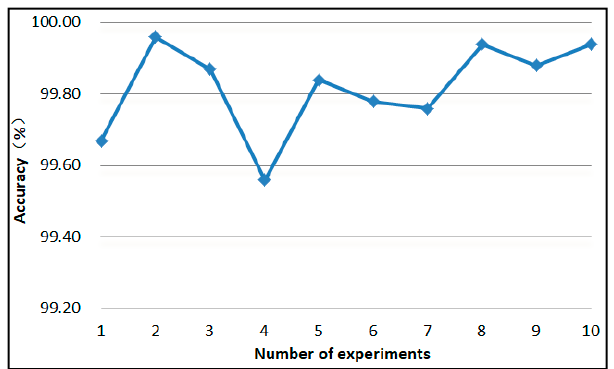
Figure 10. Accuracy of ten experiments (test set of